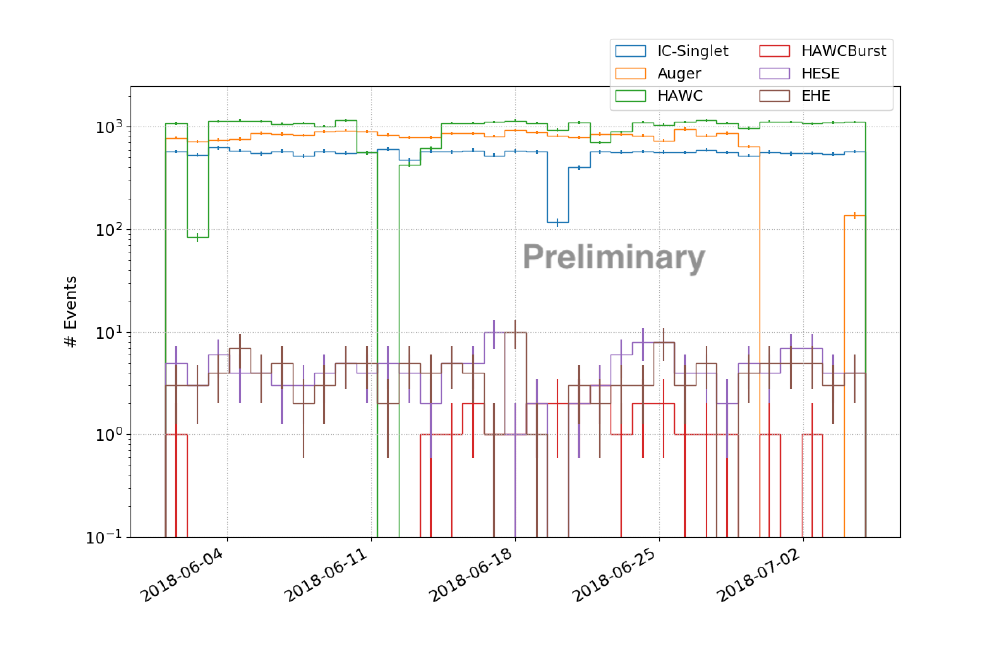
Figure 3. Rates of selected streams received by AMON. The plot shows the number of events per day received during the month of June